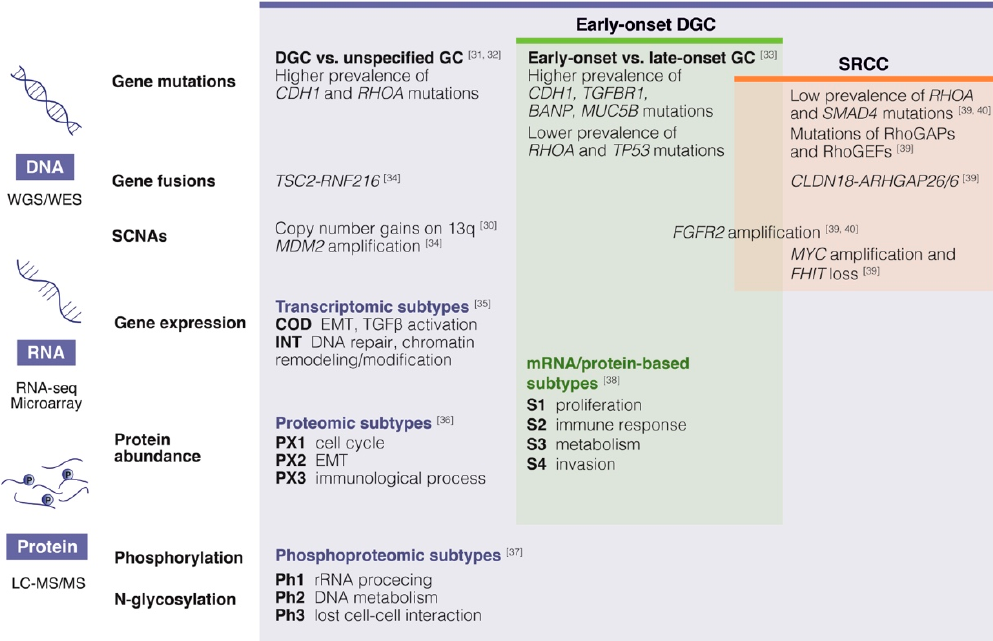
Figure1. Genomic,transcriptomicandproteomicalterationsofdiffusetypegastriccancer[30–40]. DGC,diffuse Figure 1. Genomic, transcriptomic and proteomic alterations of diffuse type gastric cancer [30–40] . type gastric cancer; EMT, epithelial-to-mesenchymal transition; LC-MS / MS, liquid chromatography-tandem DGC, diffuse type gastric cancer; EMT, epithelial-to-mesenchymal transition; LC-MS/MS, liquid mass spectrometry; SCNA, somatic copy number alteration; SRCC, signet-ring cell carcinoma; WGS / WES, chromatography-tandem mass spectrometry; SCNA, somatic copy number alteration; SRCC, signet- whole genome sequencing / whole exome sequencing. Reference numbers are shown in square ring cell carcinoma; WGS/WES, whole genome sequencing/whole exome sequencing. Reference numbers are shown in square brackets.